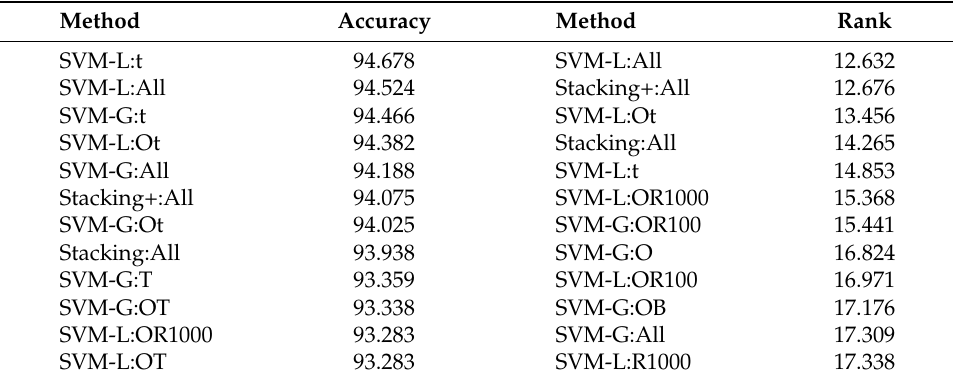
Table 4. Average accuracies and ranks from all the